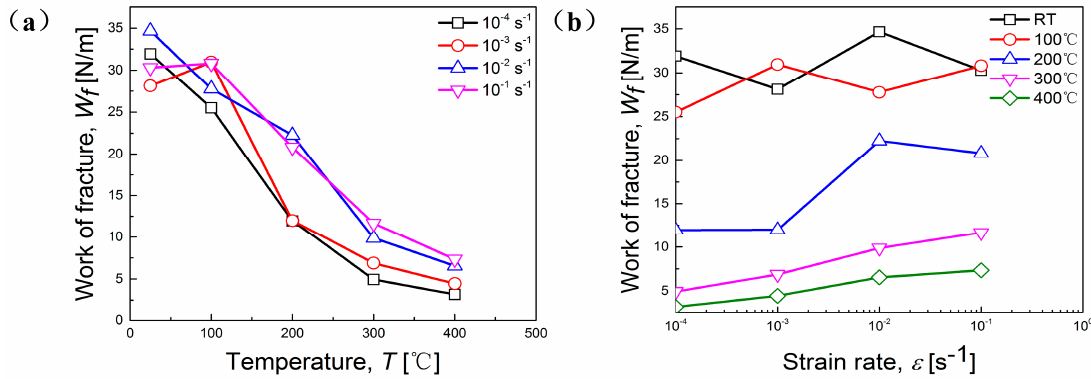
Figure 7. Work of fracture ( W f ) versus ( a ) temperature at different strain rates; ( b ) strain rate at different temperatures.